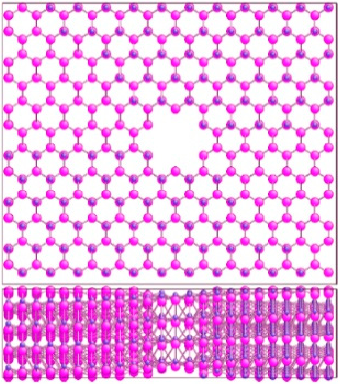
Figure 5. Structural model of GaN threading dislocation [40].